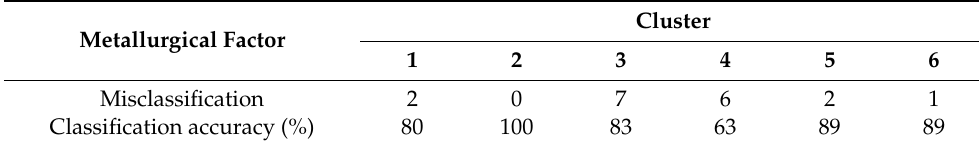
Table 7. The accuracy of each